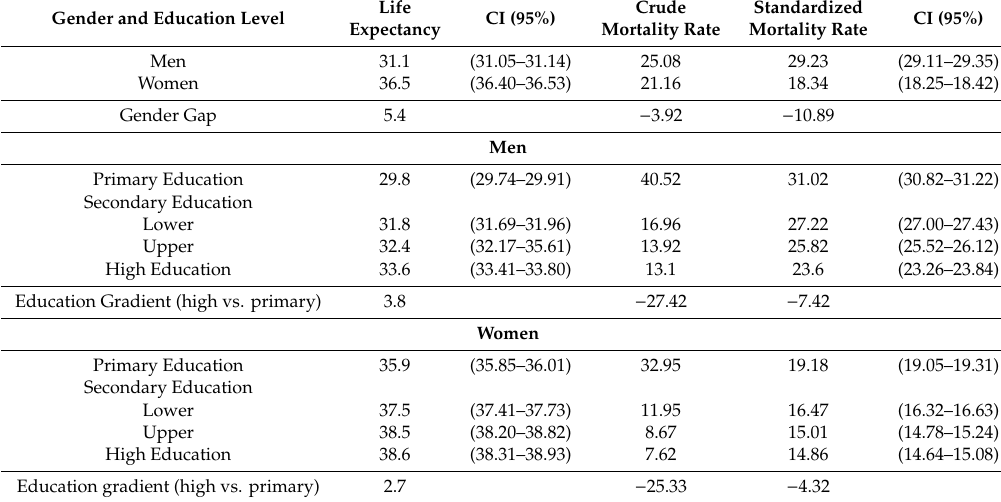
Life expectancy, crude, and standardized mortality rates at age 50 by gender and educational